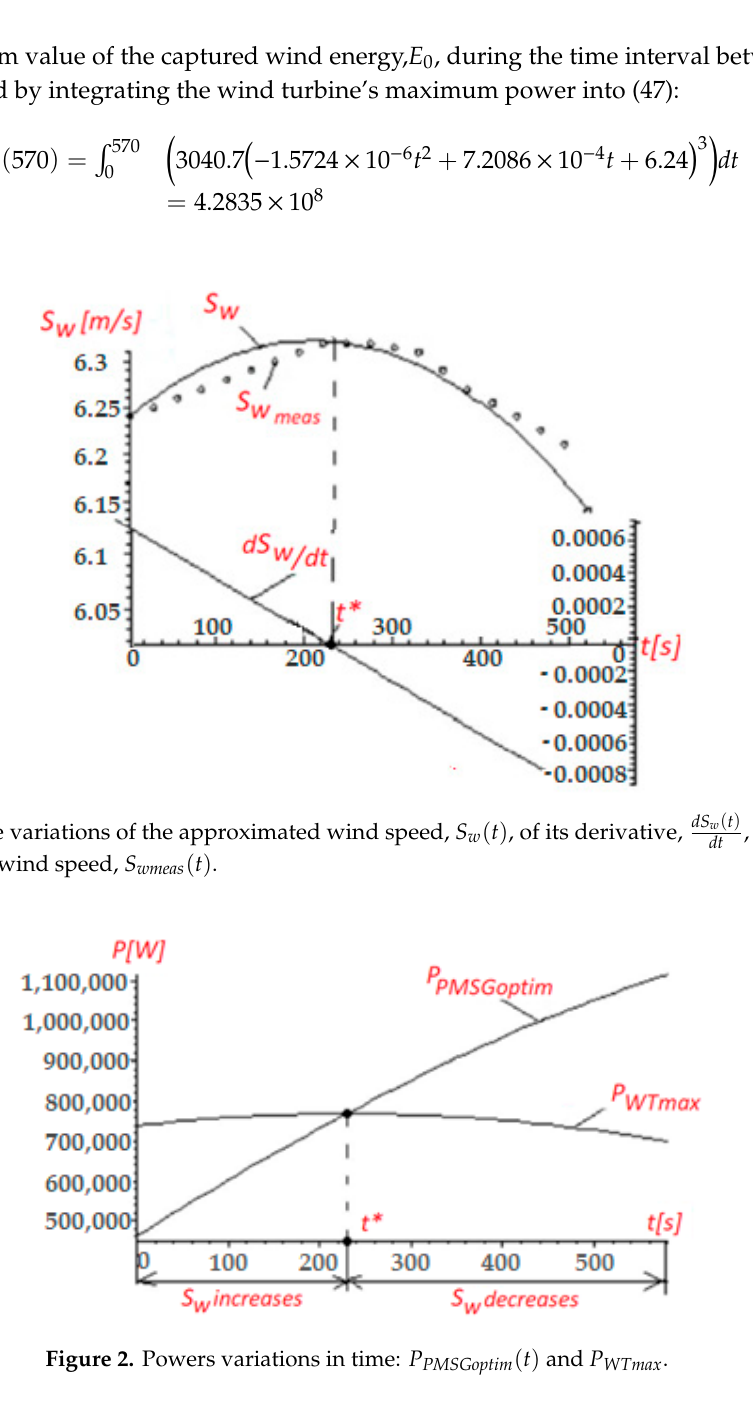
Figure 2. Powers variations in time: P PMSGoptim ( t ) and P WTmax